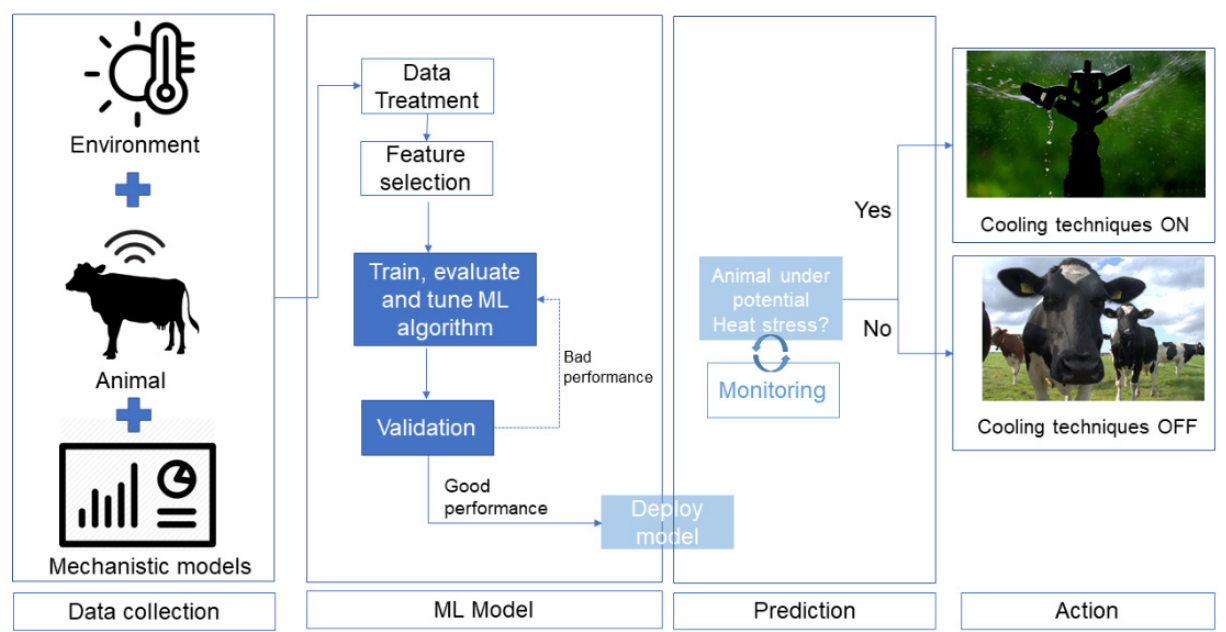
Figure 1. General tasks associated with the implementation of ML techniques to predict the herd thermal state.